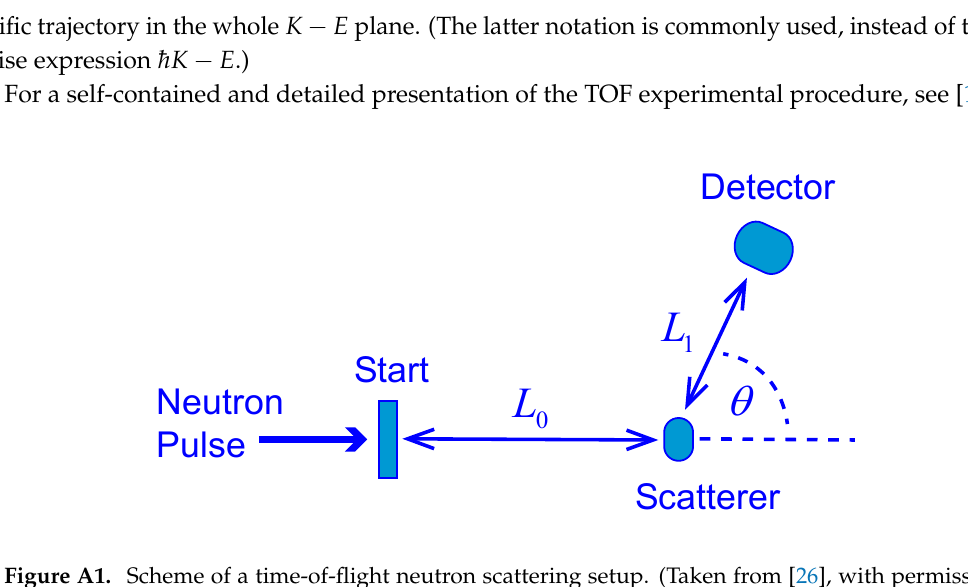
Figure A1. Scheme of a time-of-flight neutron scattering setup. (Taken from [26], with permission of